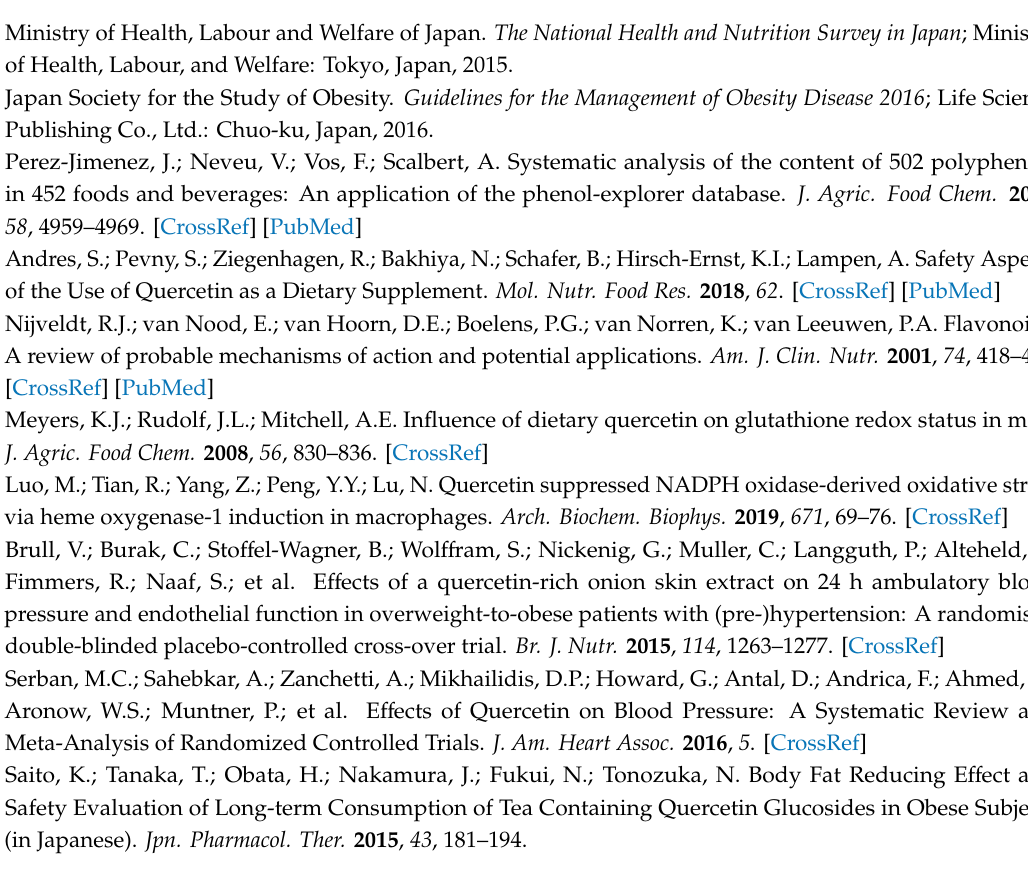
Table S1: Dietary nutrients for the placebo and quercetin-rich onion groups, Table S2: Complete blood counts, renal function, lipid profile and blood glucose profile, Table S3: Adverse